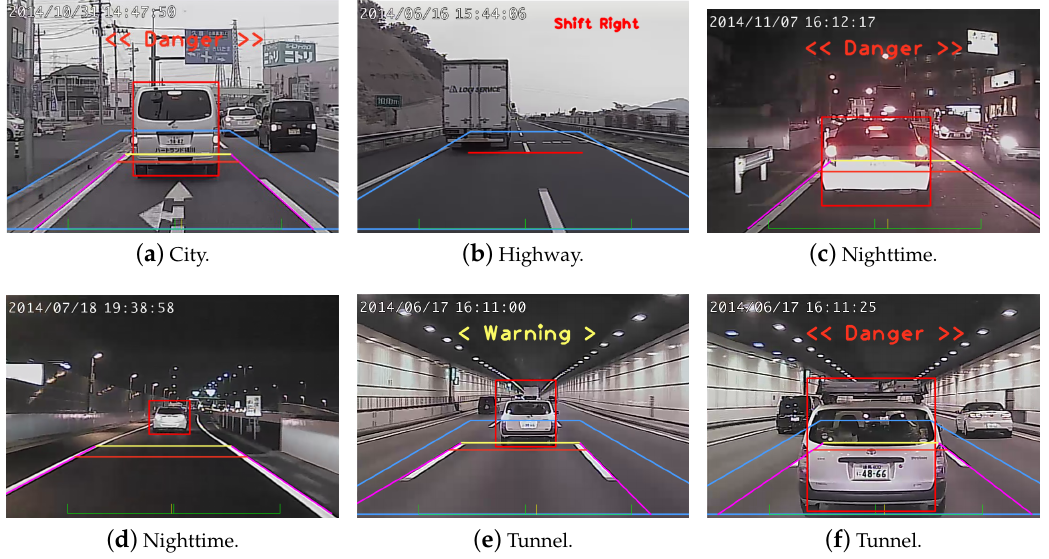
Figure 14. The results of forward collision warning. The images contain city, highway, nighttime, and tunnel traffic